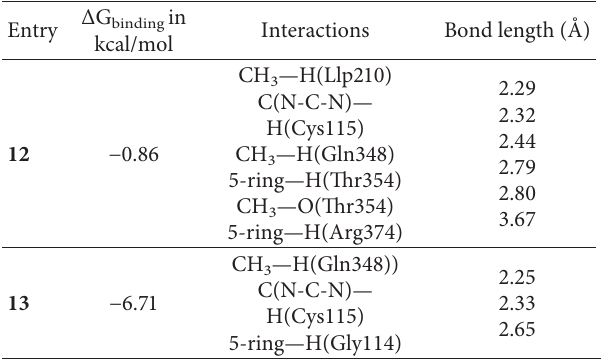
Figure S1: 1 H NMR spectrum of N-((3,5-dimethyl-1H- pyrazol-1-yl)methyl)pyridin-2-amine ( 1 ). Figure S2: 13 C